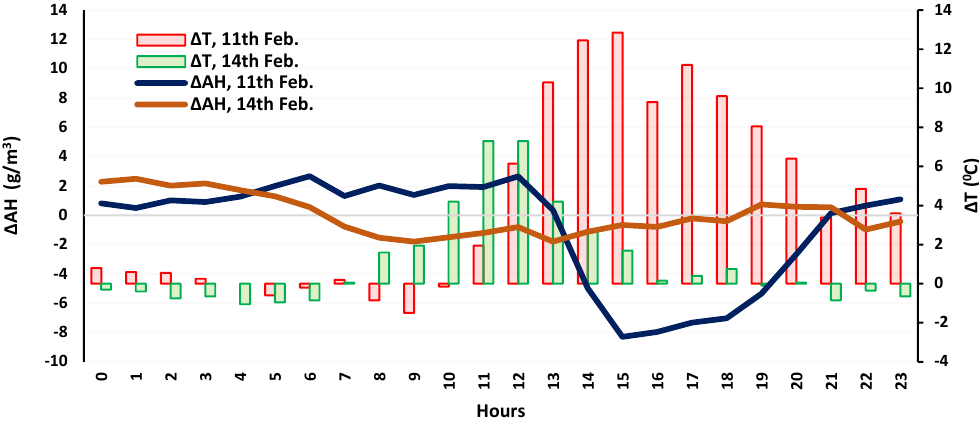
Figure 3. Absolute humidity difference (ΔAH) and urban-overheating (ΔT) between Penrith Lakes—OBS Hill during selected HW (11 February 2017) & NHW (14 February 2017) days.